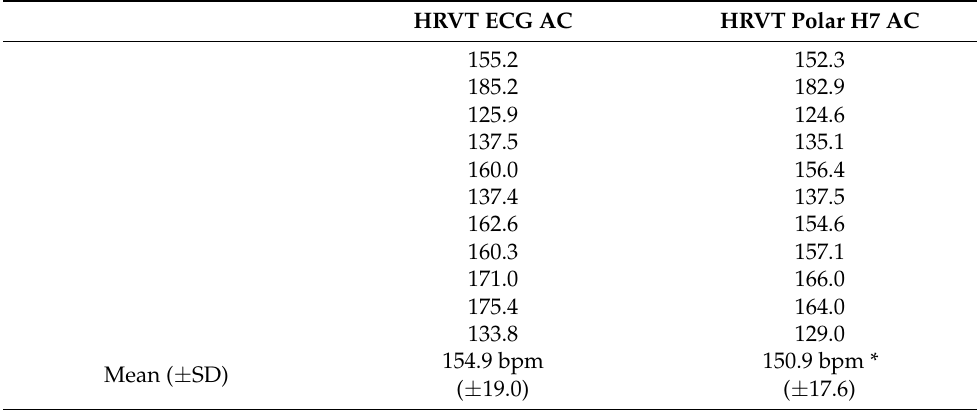
Table 3. Comparison of heart rate at HRVT between ECG vs. Polar H7 data both using automatic artefact correction (AC). Percent artefact for all data calculated over the HRVT measurement range below 5%. Mean ( ± standard deviation, SD) in last row. * denotes p ≤ 0.05 on paired t